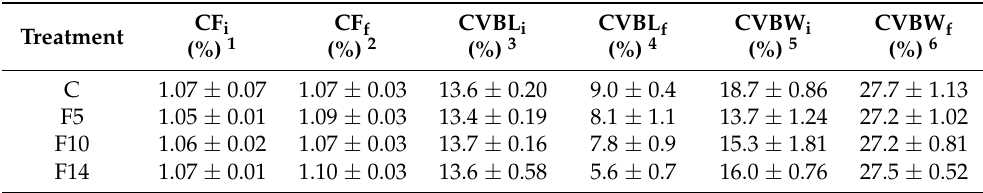
Table 1. Condition factor (CF), coefficient of variation for body length (CVBL), and body weight (CVBW) of juvenile leopard mandarin fish ( Siniperca scherzeri ) subjected to four different feeding regimens for 8 weeks *.